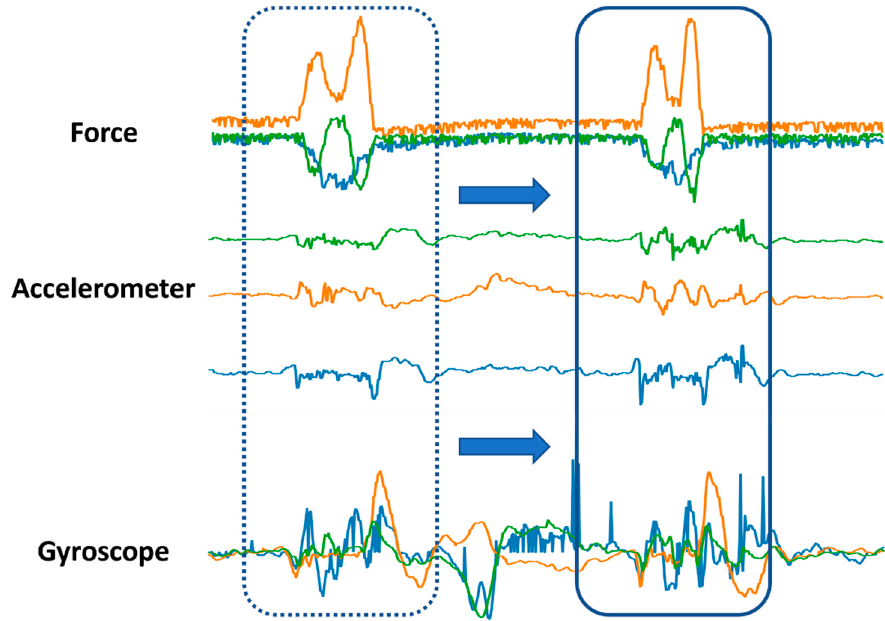
Figure 4. Dataset construction through segmentation. The units are [N], [g], and [deg/s] for the force, accelerometer, and gyroscope, respectively.